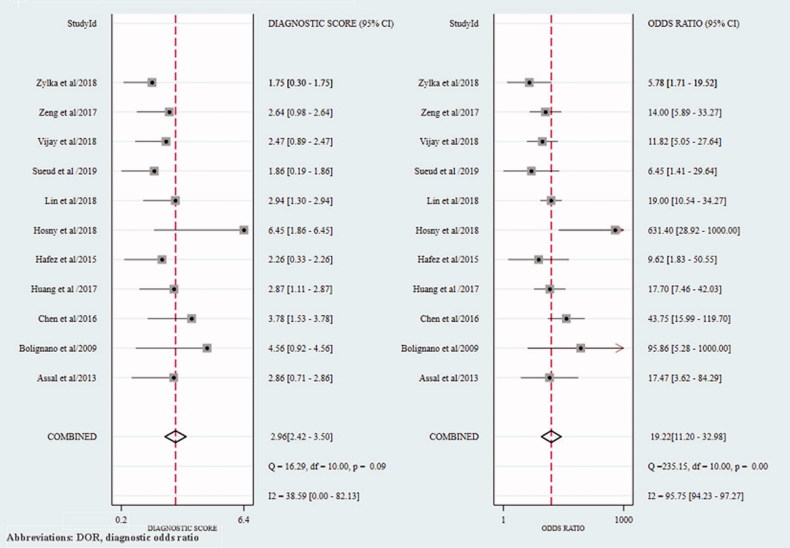
The forest plot of DOR of cross-sectional studies. DOR: diagnostic odds ratio.